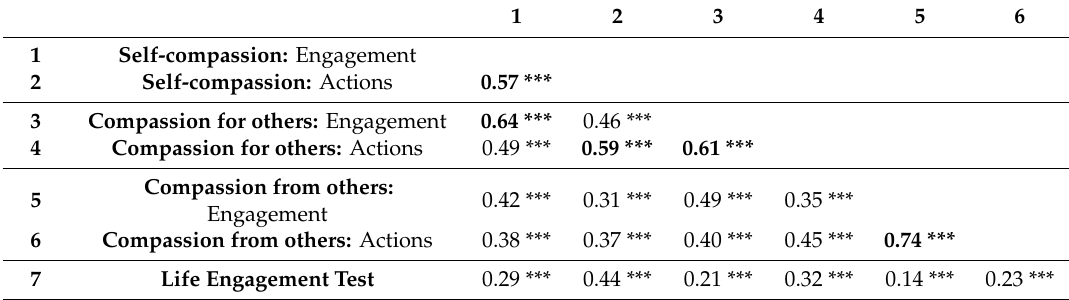
Table 7. Correlation between the compassion subscales (Gilbert’s scale): self-compassion, compassion for others, compassion from others; and the Life Engagement Test among the students (n =